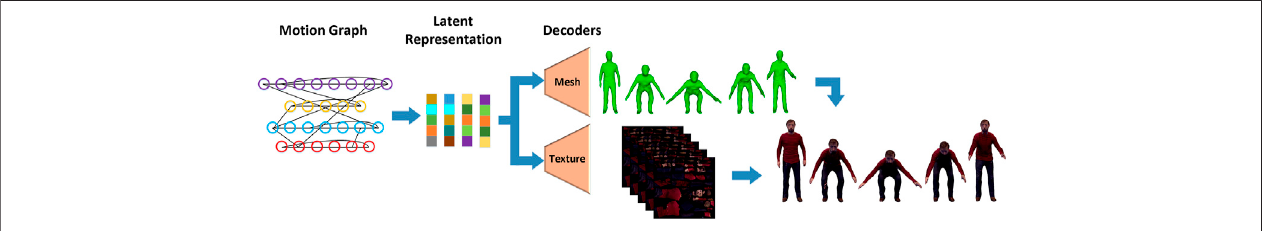
FIGURE5| Animationframeworkpipeline.Theimageillustratestheonlineblockthatgenerateshigh-resolution4Dvolumetricvideo.The4DMotionGraphcontains the learnt motion representation allowing the decoders in real-time to synthesise 4D volumetric video sequences consisting of 4D mesh, 2D texture appearance.